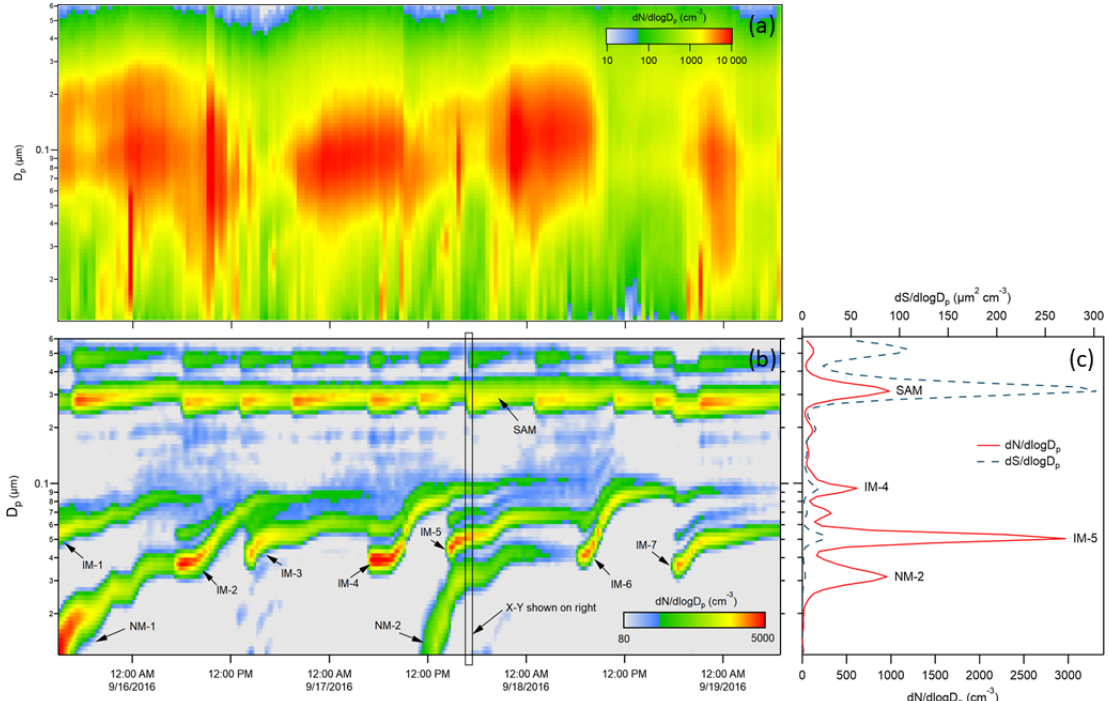
Figure 10. (a) Ambient aerosol size distribution time series over 3.5d during the 2016 study. (b) Chamber A size distribution time series over the same period. IM = injected mode, NM = nucleation mode, SAM = surface area mode. (c) x − y presentation of the size distribution measured at the time indicated by the rectangle in the intensity graph. N = number concentration and S = surface area concentration.